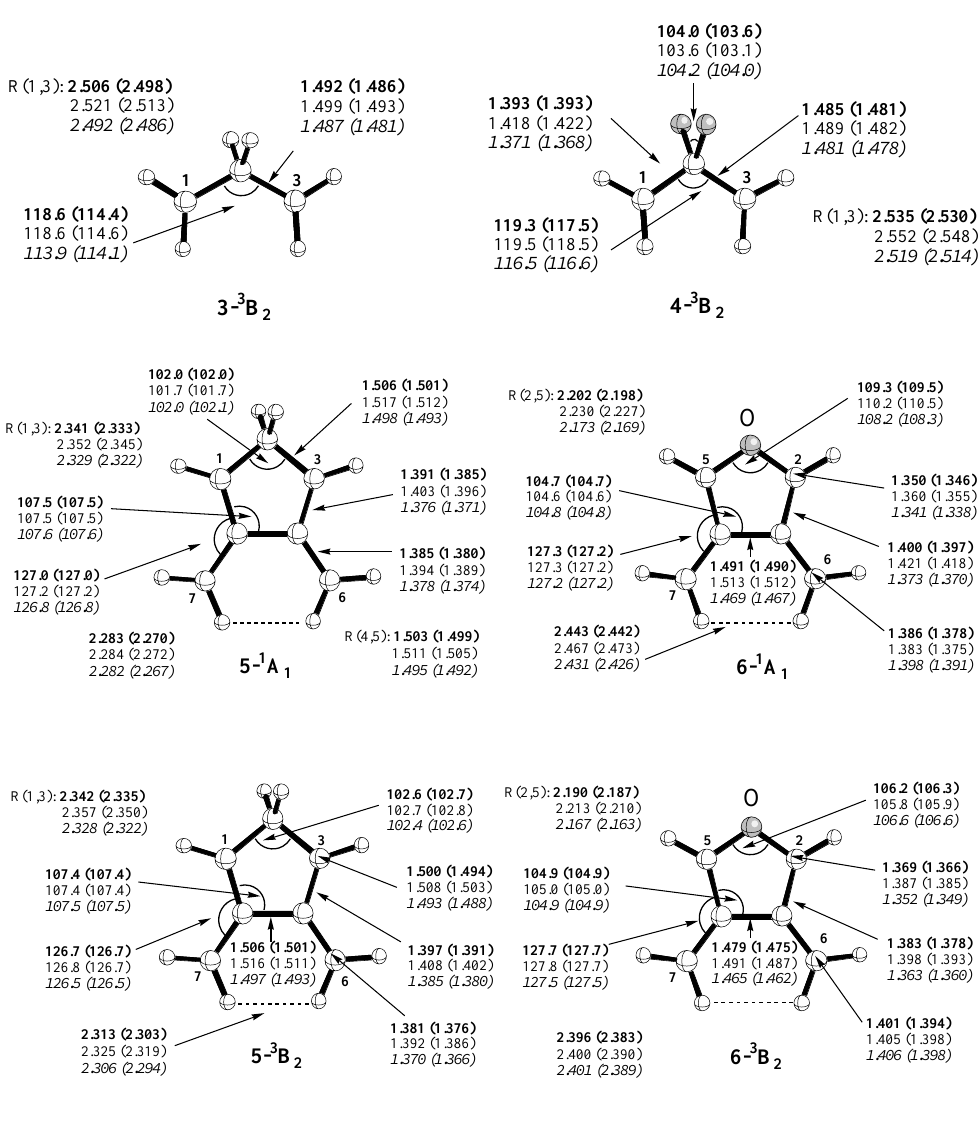
Figure 5: REKS(2,2)/6-31G(d) geometries of the lowest singlet and triplet state of biradicals 1 - 6 . B3LYP: values in bold print, BLYP: normal print, BH&HLYP: italics. Numbers in parentheses were obtained with the cc-pVTZ basis set. Distances in ˚A, angles in